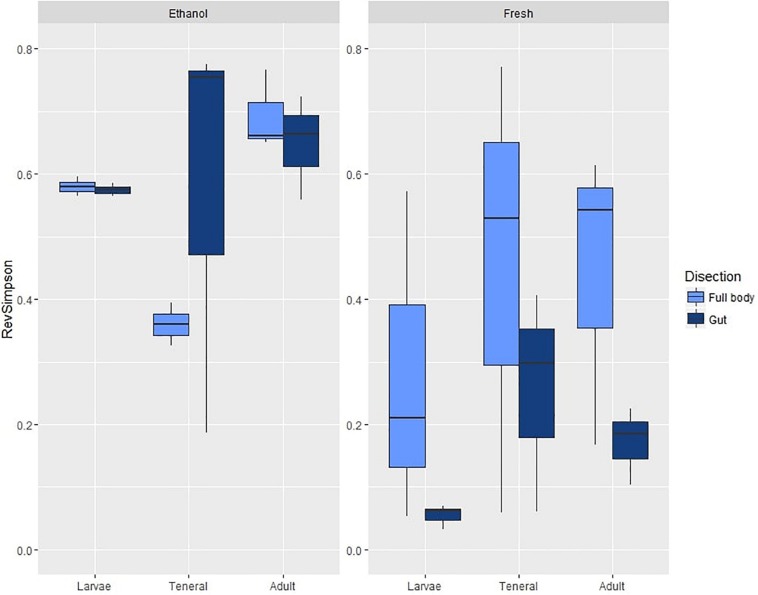
Box plots of OTU diversity (as estimated by the Reverse Simpson index) of microbial assemblages in ethanol preserved/fresh and gut/full body specimens of C. capitata. Standard deviations are shown as error bars.